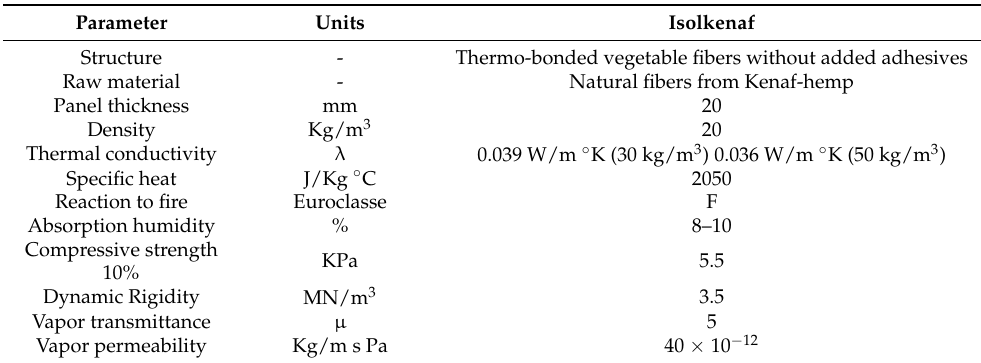
Table 1. Morphological and physical-mechanical characteristics. www.euchora.com (accessed on 26 July